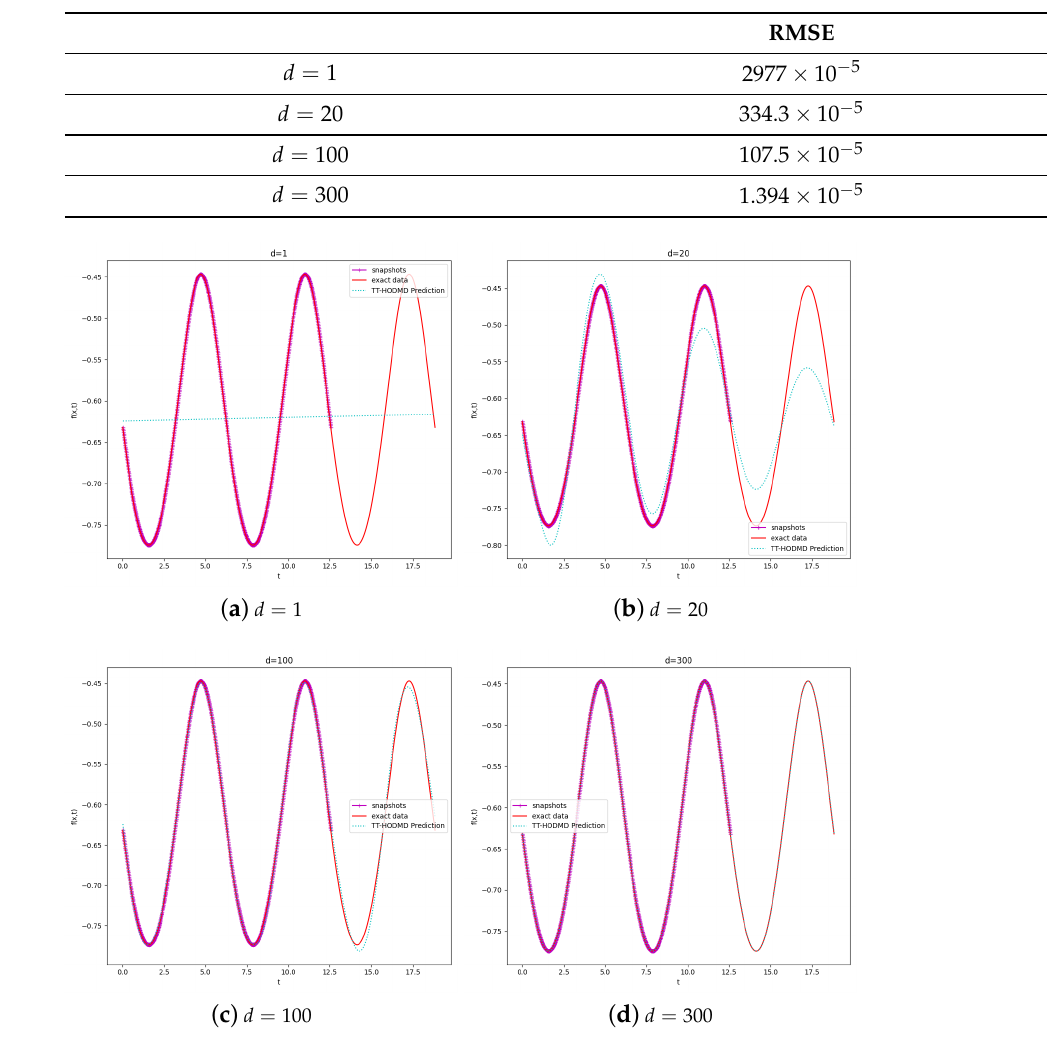
Table 1. RMSE of different d .